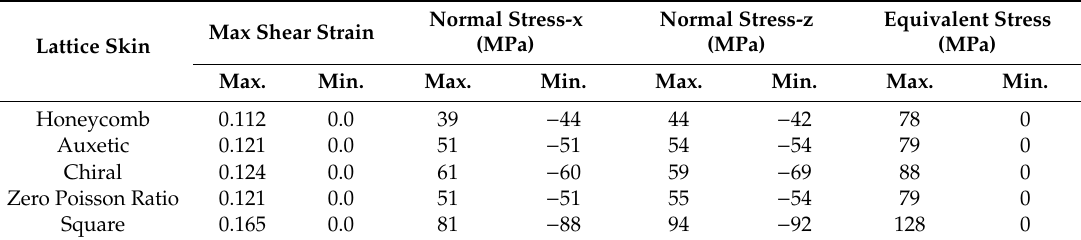
Table 3. Flexible skin models’ mechanical properties for the step morphing case.